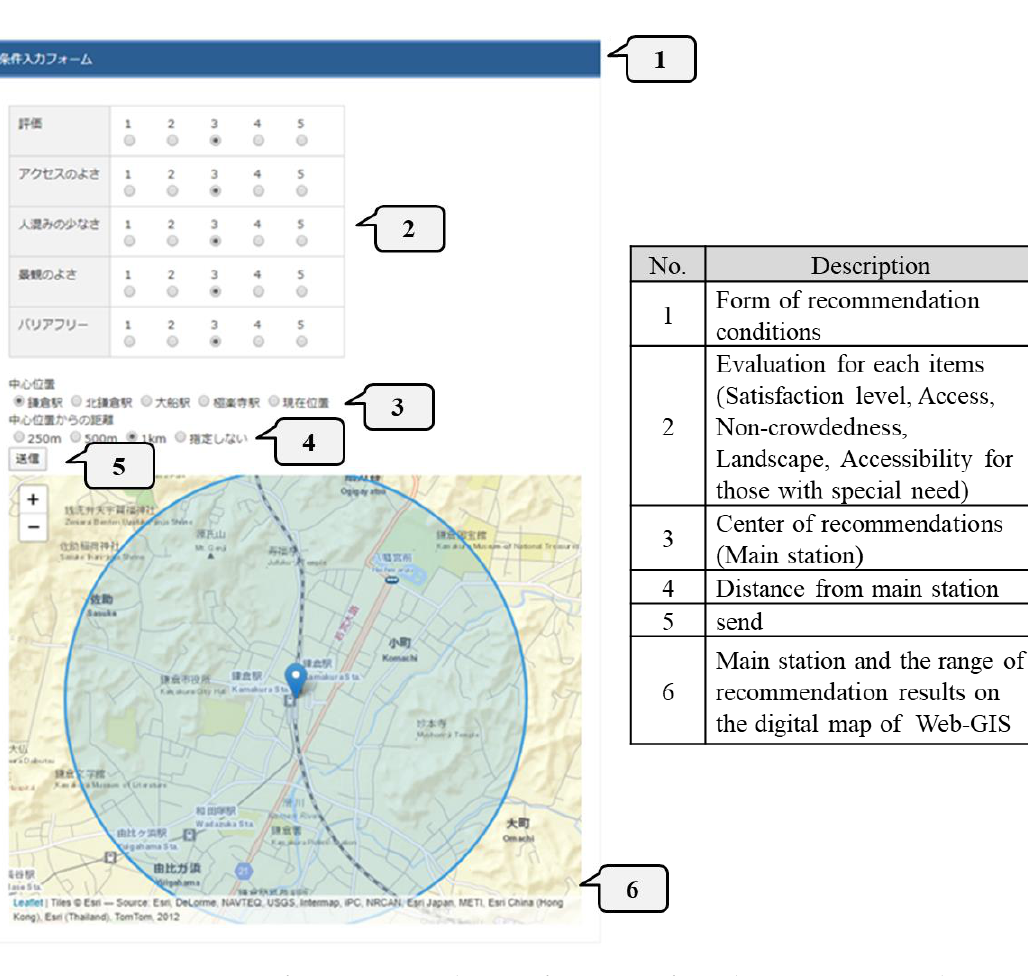
Figure 6. Page for recommendation function of sightseeing pots adopting knowledge-based recommendations.